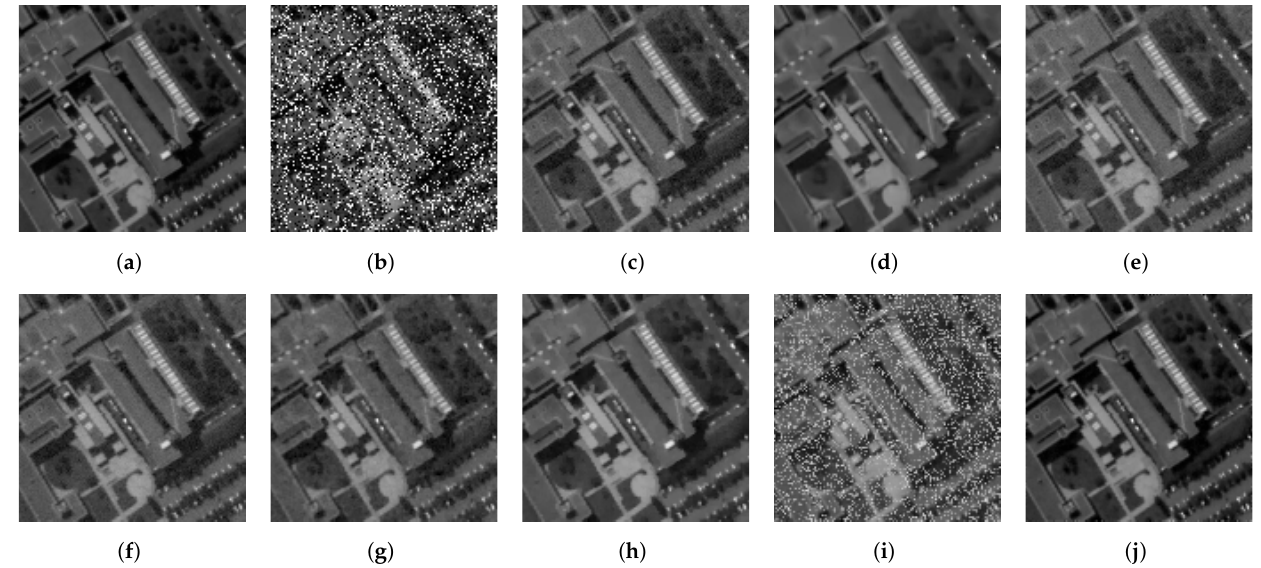
Figure 6. Case 2: The comparison of HSIs denoising results with existing methods on the Pavia University dataset: ( a ) ground truth of band 27; ( b ) noisy image; ( c ) NNM; ( d ) BM4D; ( e ) WNNM; ( f ) WSNM; ( g ) LRTDTV; ( h ) 3DTV; ( i ) FastHyDe; and ( j ) the proposed method. In Figure 7, the Gaussian noise cannot be completely removed by the NNM, WNNM, WSNM and LRTDTV methods and the FastHyDe method cannot remove impulse noise. In Figure 8, impulse noise and deadlines cannot be completely reduced by FastHyDe method, and Gaussian noise is still in the images denoised by the NNM, WNNM and WSNM methods. The proposed method achieves better performance compared with these existing methods.